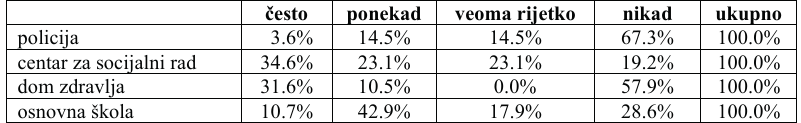
Tabela br. 5: Da li ste izrađivali indi vidualne planove intervencij a prema korisnicima ili klijentima/učenicima?